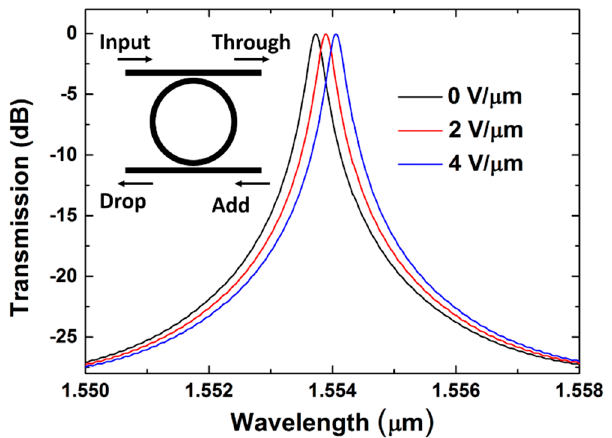
Figure 8. Graph showing the transmission spectra for the drop port of the LT microring at differ- ent electric field intensities.